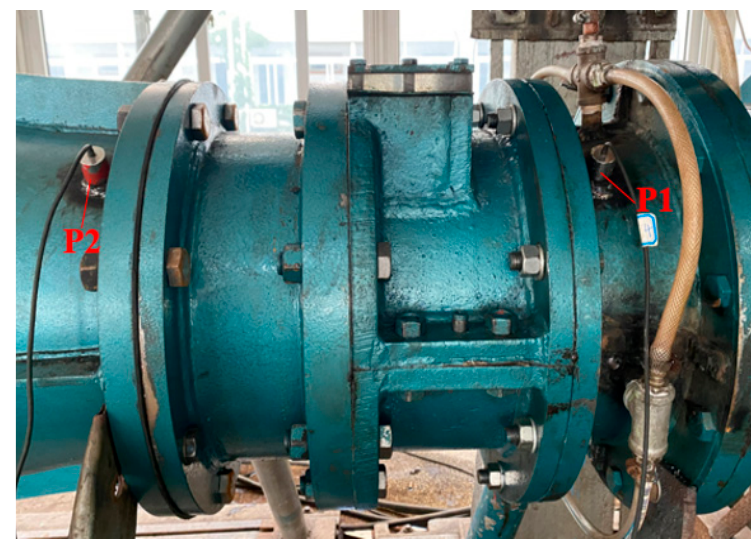
Figure 6. Installation position of pressure pulsation sensors.